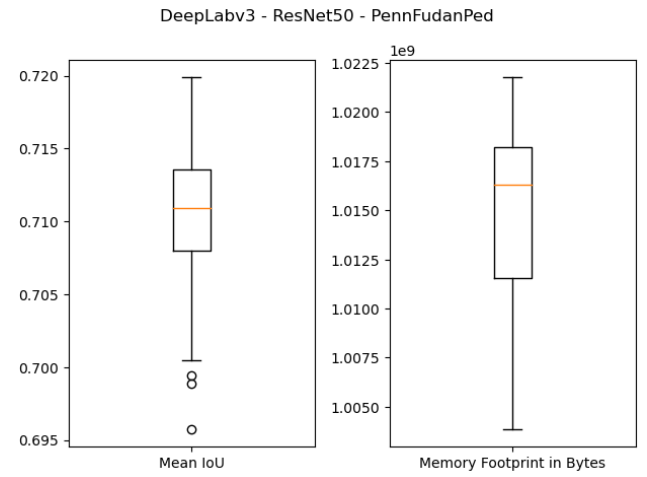
Figure 8. Boxplot results for the Penn–Fudan dataset using the ResNet50 backbone and 1 GB of desired memory footprint.